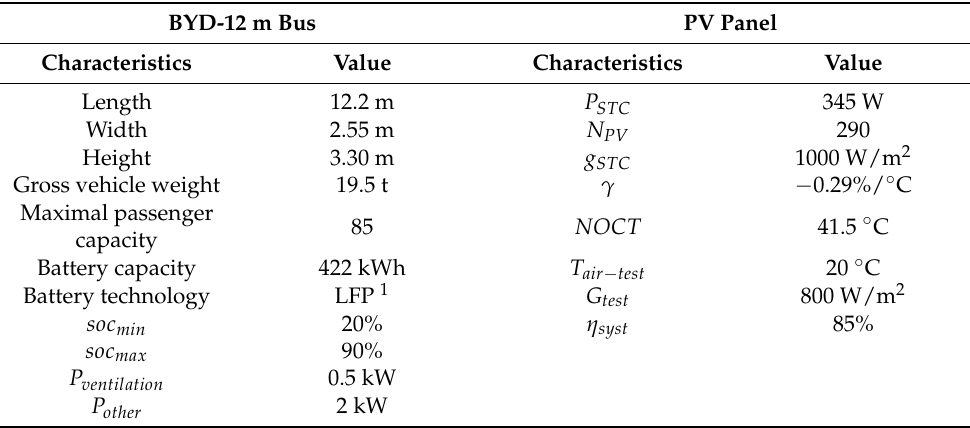
Table 2. Characteristics of the BYD-12 m bus and the PV panels. BYD-12 m Bus PV Panel Characteristics Value Characteristics